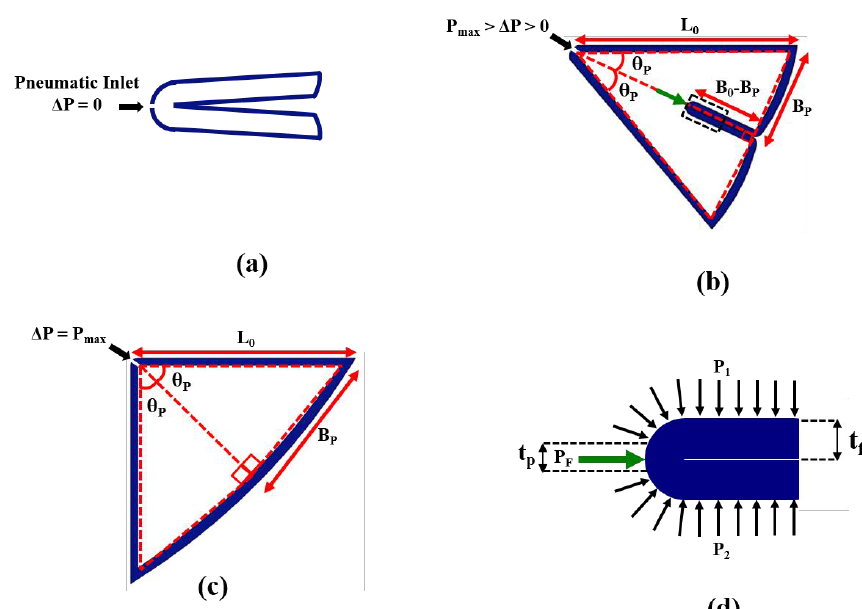
Figure 7. ( a ‒ c ) Simplified illustration of FRA module outline at different pneumatic pressure, ( d ) enclosed view of the dotted section in (b).